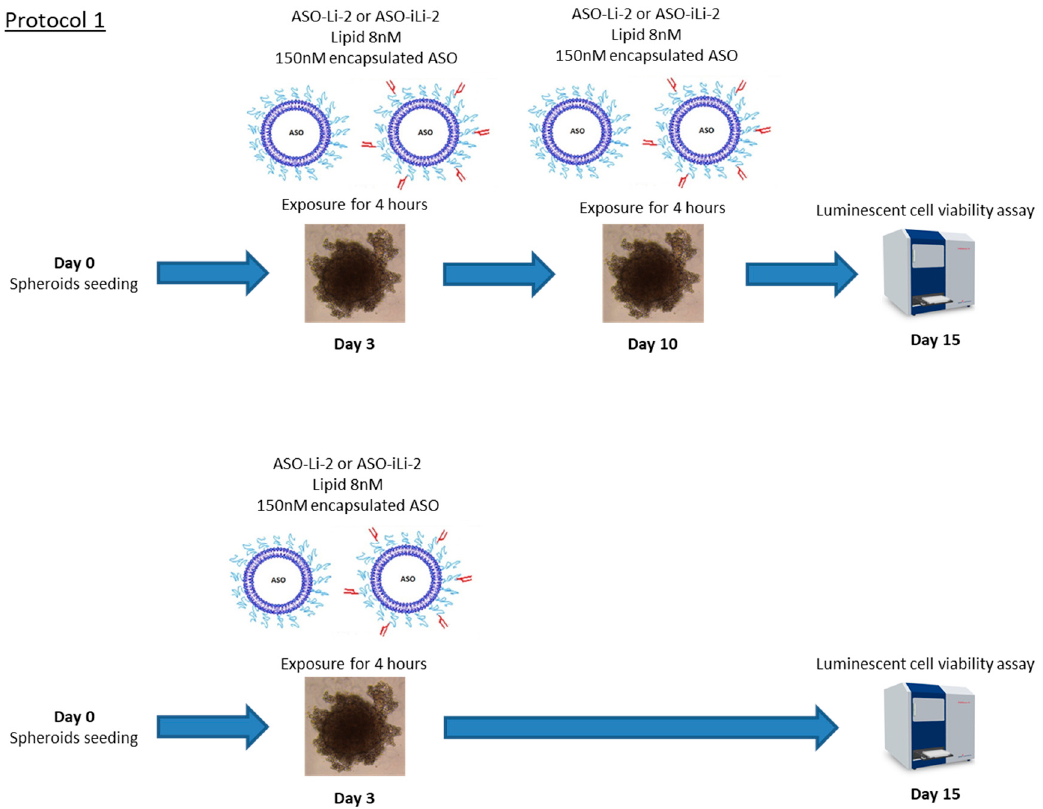
Figure 6. Protocol 1: liposomal antiproliferative activity with short exposition time. 3D in vitro assessment with spheroid treatment protocol 1. All the measures were performed in triplicate.